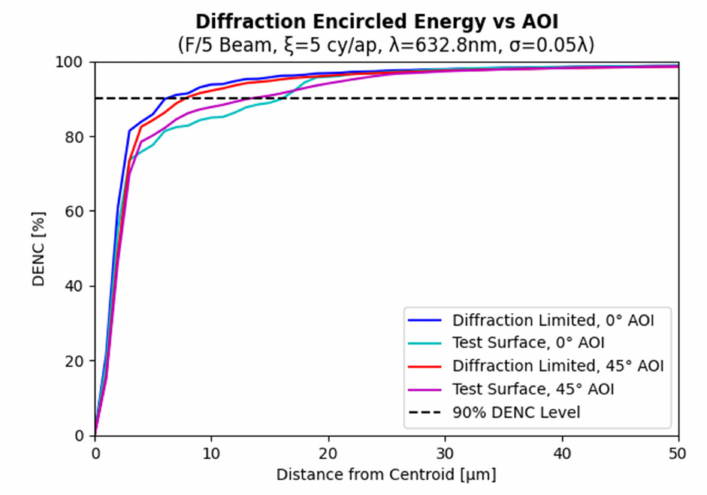
Figure 9. Example of fraction of encircled energy dependence on mirror AOI. Mirror set as system pupil. Footprint projected at 45 ◦ yields lower difference between diffraction limited case and test surface case when compared to equivalent normal incidence